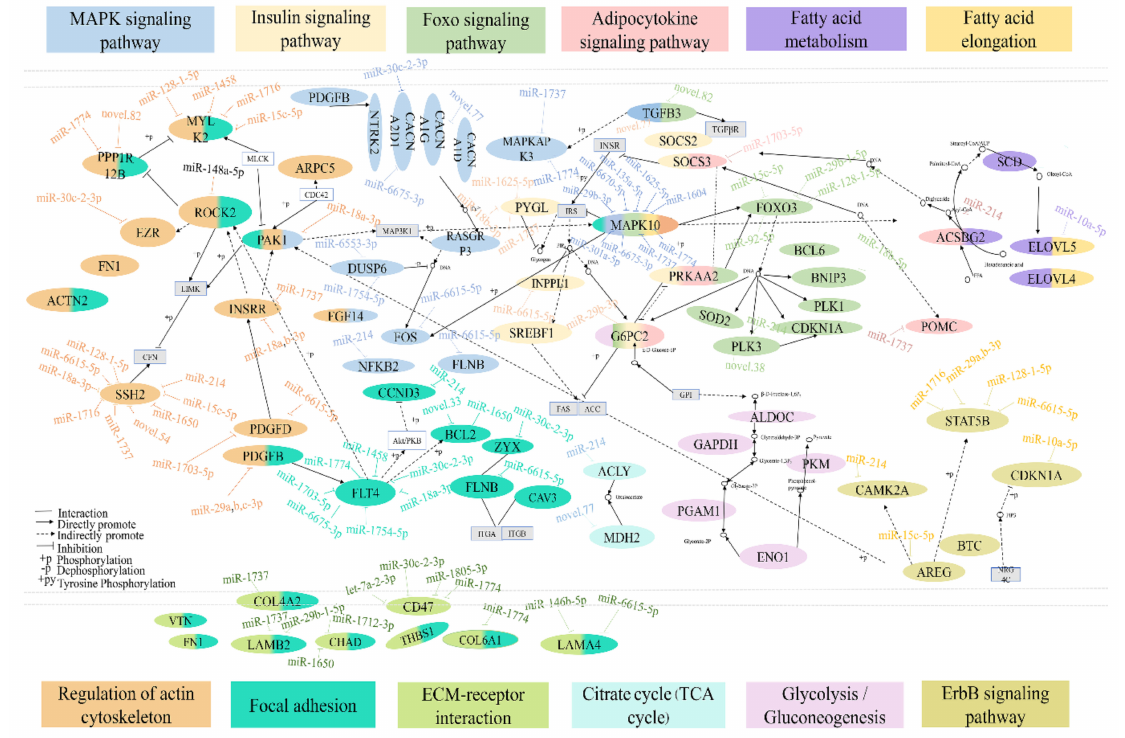
Figure 5. An interaction network of the DEMs and DEGs across twelve pathways during lipid metabolism in